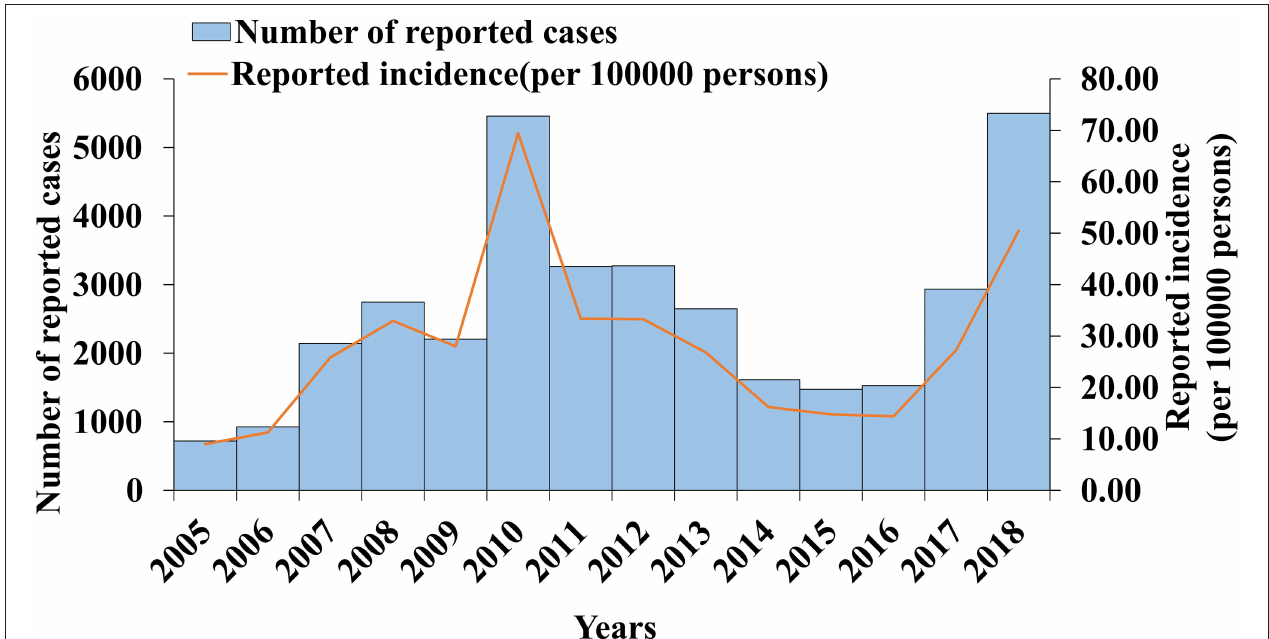
FIGURE 2 | Mumps cases and incidence rate in Wuhan City in